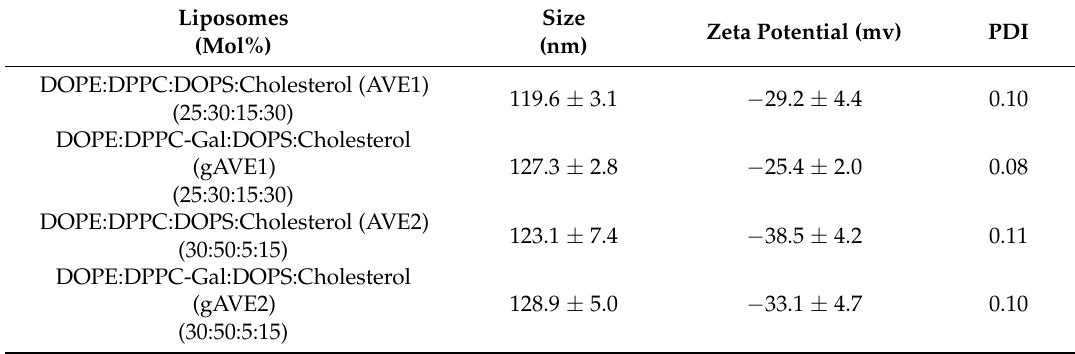
Table 1. Hydrodynamic diameter (by intensity) and zeta potential of the liposomal formulations. Liposomes